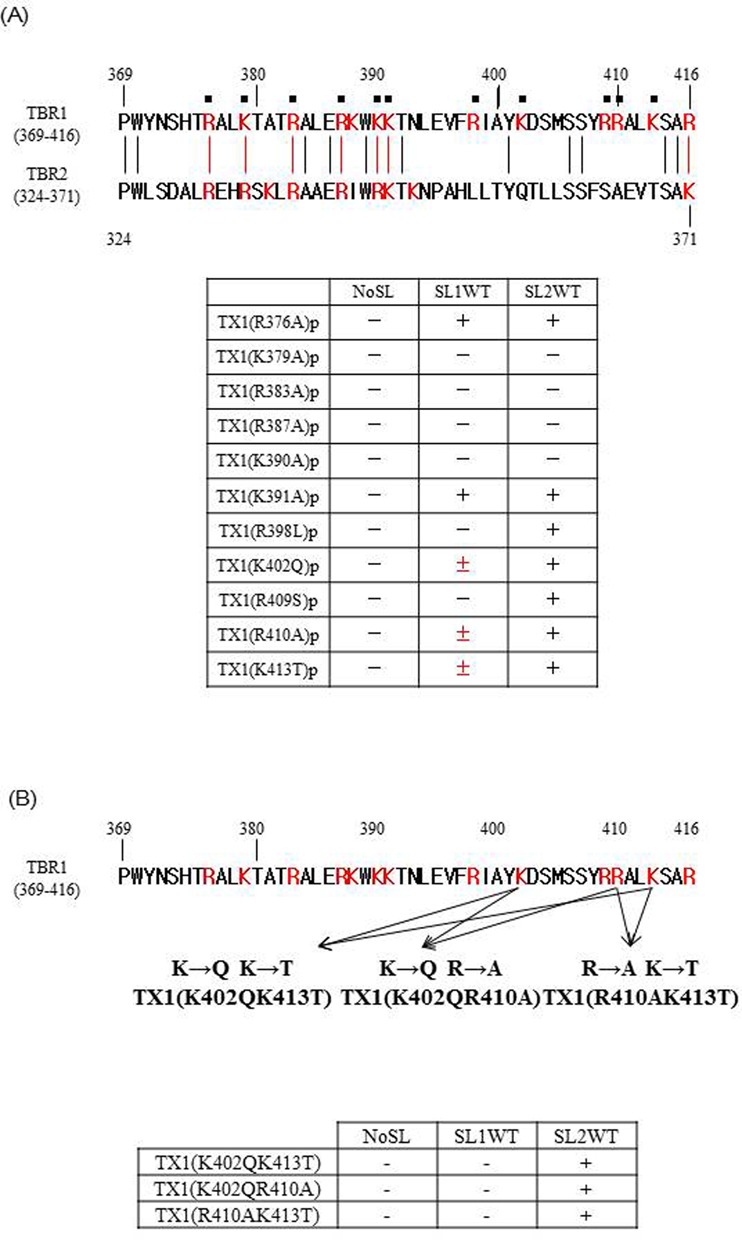
Basic residues in TBR1 (369–416) are responsible for binding the stem-loop RNA. Identical non-basic residues between sequences are indicated by black lines, and similar basic residues are indicated by red lines. Numbers indicate residue positions. Each (+) indicates that the protein can bind the RNA, and each (–) indicates no RNA binding, i.e. the binding was the same as that for the RNA lacking the stem-loop (NoSL). (±) indicates that there was no significant difference statistically, although the binding activity of SL1WT of TX1(K402Q)p, TX1(R410A)p and TX1(K413T)p is higher than that of NoSL. (A) Binding assay using TBR1(369–416) containing mutated basic residues common to TBR1 and TBR2. TBR1(369–416) in ZfL2-1 and TBR2(324–371) in ZfL2-2 are aligned. Binding assay using TBR1(369–416) containing mutated basic residues specific to TBR1. (B) Binding assay with three mutant proteins, namely TX1(K402QK413T)p, TX1(K402QR410A)p and TX1(R410AK413T)p. Red characters indicate basic residues. Five independent experiments were done for each protein.